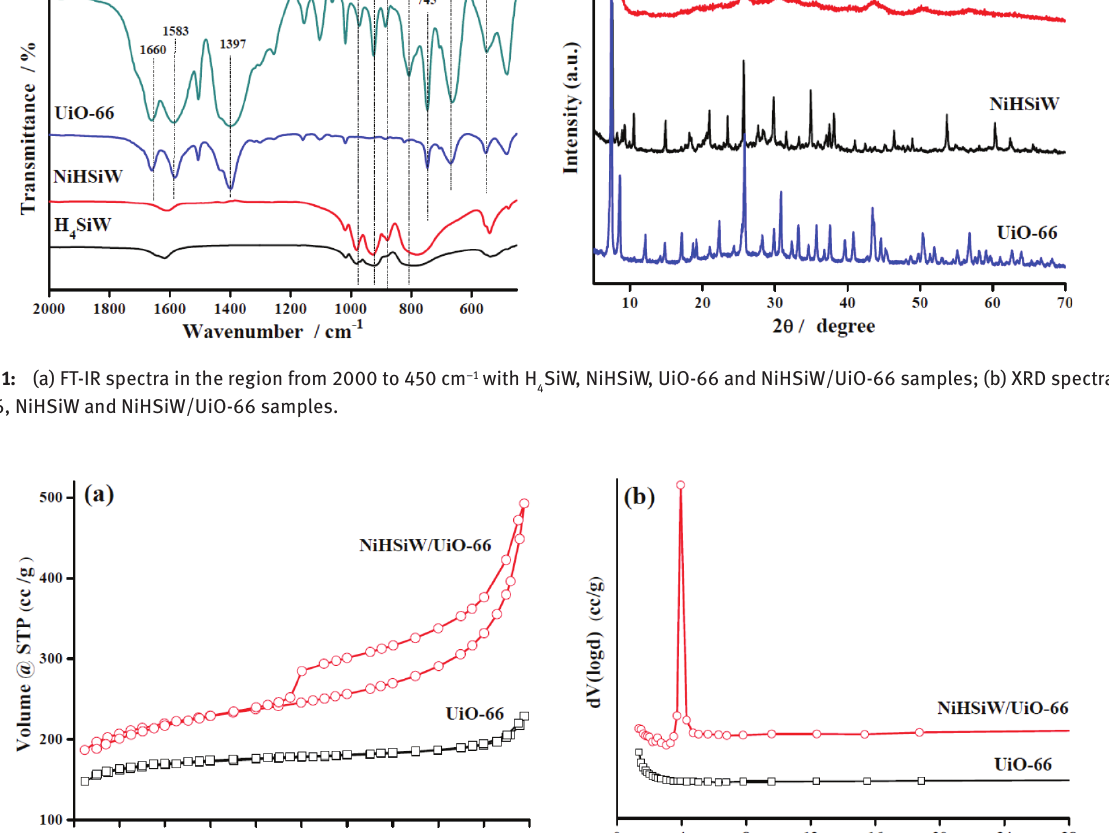
adsorptionedesorption isotherms and (b) pore size distribution of UiO-66 and NiHSiW/UiO-66 Figure 2: (a) N 2